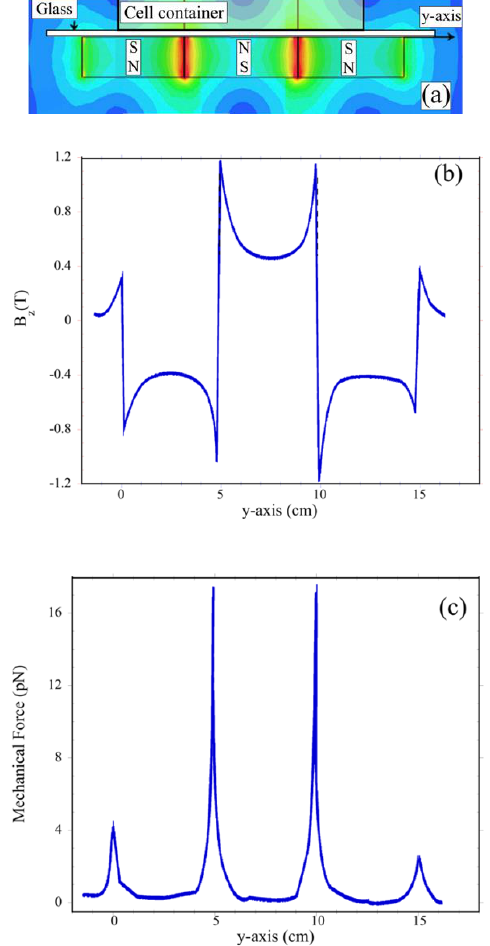
Figure 2. Magnetic field induction B and magnetic field-induced mechanical force patterns. ( a ) Sketch of the experimental configuration of the magnets and the cells’ container position. The di- mensions of the glass plate, magnets, and container are not to scale. The theoretically calculated magnetic induction vector component, B z , in the y - and z -planes is 2D plotted along the y -axis. ( b ) The mechanical force acting on a cell along the y -axis is shown. Calculations were conducted for three very closely aligned 5 mm wide, 10 mm long, and 1.9 mm thick magnets configured in oppo- site magnetic polarization (NS – SN) directions. 2.2. The Magnetic field Gradient Created a Mechanical Force Acting on Macrophages The nature and magnitude of the interactions of the electric and magnetic fields with cells or tissue depend on the polarizations produced by such fields. The ability to induce polarization is characterized by electric and magnetic field susceptibilities. There were significant differences between the interactions of these fields with cells/tissue, because for a typical tissue, the electric field susceptibility is 10 5 – 10 6 larger than the magnetic field susceptibility and, as a result, the electric field can cause significant cells/tissue damage, whereas magnetic field interactions with cells/tissue are relatively weak due to the weak diamagnetism of the cells. Magnetic field-induced forces are, in most cases, smaller or only comparable with gravitational forces. In principle, when a diamagnetic object is sus- pended in a nonmagnetic medium, it is expelled by the magnetic field. However, the buffer or plasma medium can be either more or less diamagnetic than the cells. In such a case, the response of cells to the presence of a magnetic field depends on the difference between susceptibilities of the cell and medium.